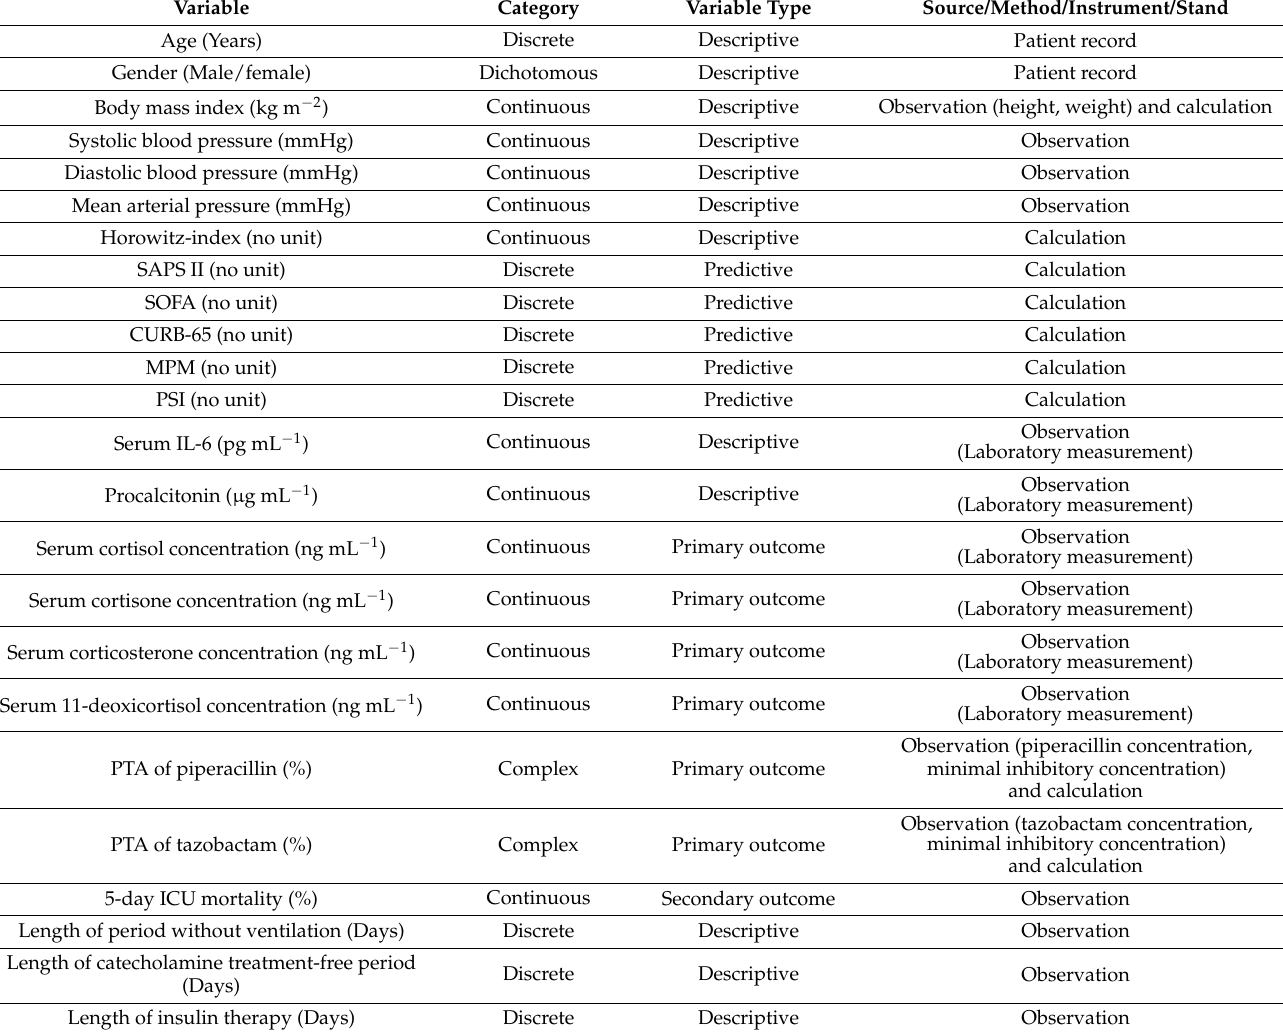
Table 3. Variables considered for evaluation. SAPS II indicates simplified acute physiology score II; SOFA, sequential organ failure assessment; CRUB-65, confusion, uremia, respiratory rate, blood pressure, age > 65 years; MPM, mortality prediction model; PSI, patient safety indicators; PTA